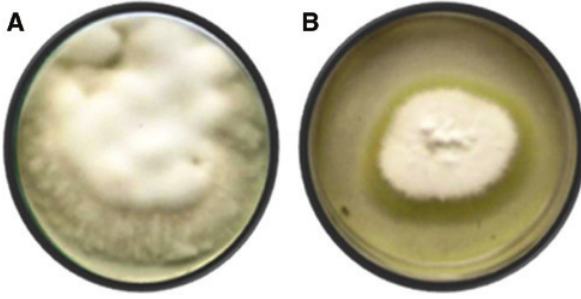
Figure 2: Cultures of dermatophytes on Sabouraud dextrose agar (SDA) medium: (A) Trichophyton mentagrophytes, (B) Trichophyton rubrum.